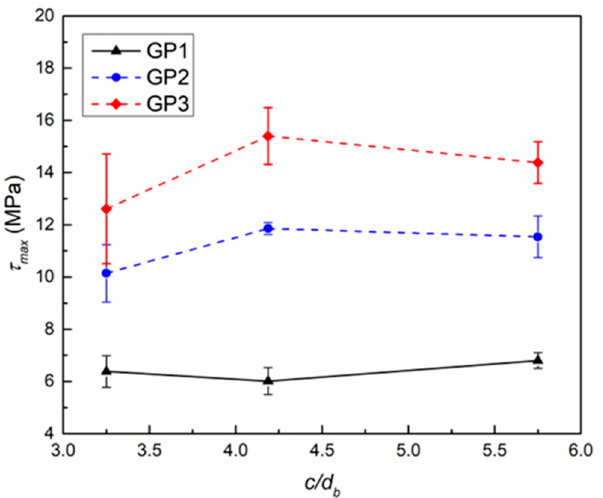
Figure 8. Relationship between diameter reinforcing bars and bond strength.